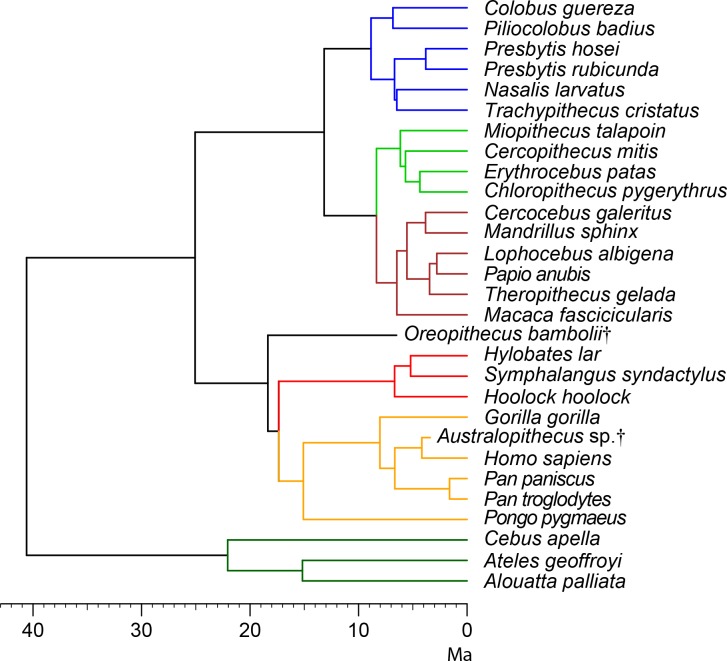
Time-calibrated molecular phylogeny of extant anthropoids used in the analyses of phylogenetic signal and PGLS regressions as inferred from a species supermatrix.Fossil taxa have been added a posteriori according to their phylogenetic position and their point estimates correspond to their last occurrence in the fossil record (Rook et al., 2000; Wood and Boyle, 2016). Oreopithecus is here considered as a stem hominoid, predating the split between hominids and hylobatids, while Australopithecus has been added following the first appearance datum for A. africanus based on the Jacovec Cavern specimens. For the phylomorphospace the phylogenetic tree has been pruned to include extant and extinct hominoids only. Branches are color-coded: dark green, platyrrhines; brown, papionins; green, cercopithecins; blue, colobines; orange, hominids; red, hylobatids. Extinct taxa are denoted by a dagger.